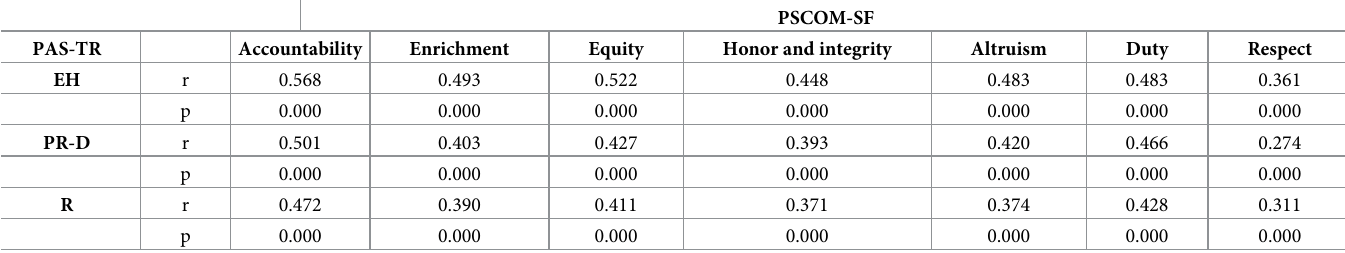
Table 7. Correlations between PAS-TR and PSCOM-SF scale